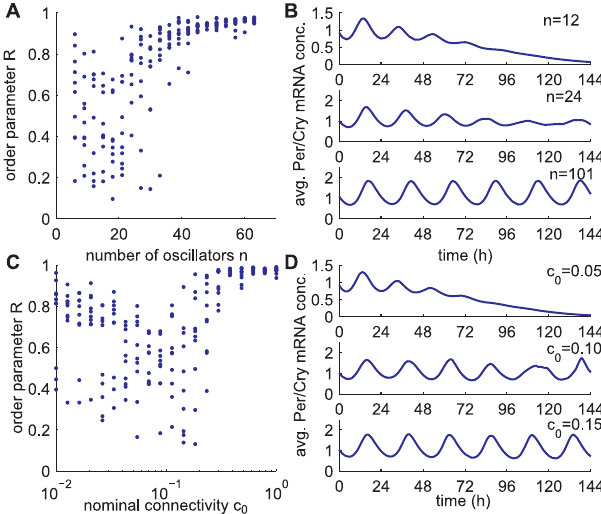
Figure 5. Effect of the Number of Oscillators as Well as the Connectivity on Synchronization (A) Synchronization properties of randomly coupled networks with respect to the number of neurons n ( c 0 ¼ 0.10). Each dot represents the order parameter R for one realization of a random network and a simulation. Ten simulations were performed for each value of cell number n . The total length of the simulations was 312 h after starting with random initial conditions, and the order parameter was calculated over the last 240 h. (B) Three examples of average output for n ¼ 12, 24, and 101. (C) Synchronization properties of randomly coupled networks with respect to the connectivity c 0 ( n ¼ 12). Ten simulations were performed for each value of nominal connectivity c 0 . Other parameters as in (A). (D) Three examples of average Per/Cry mRNA concentration for c 0 ¼ 0.05, 0.10, and 0.15.